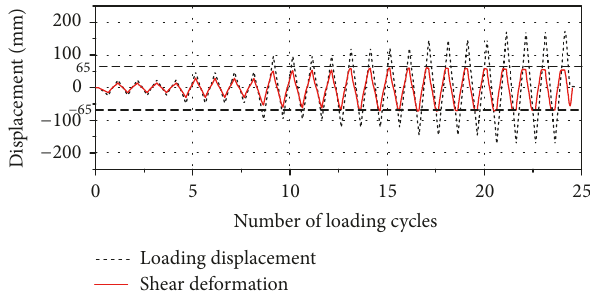
Figure 8: History curve of the friction sliding